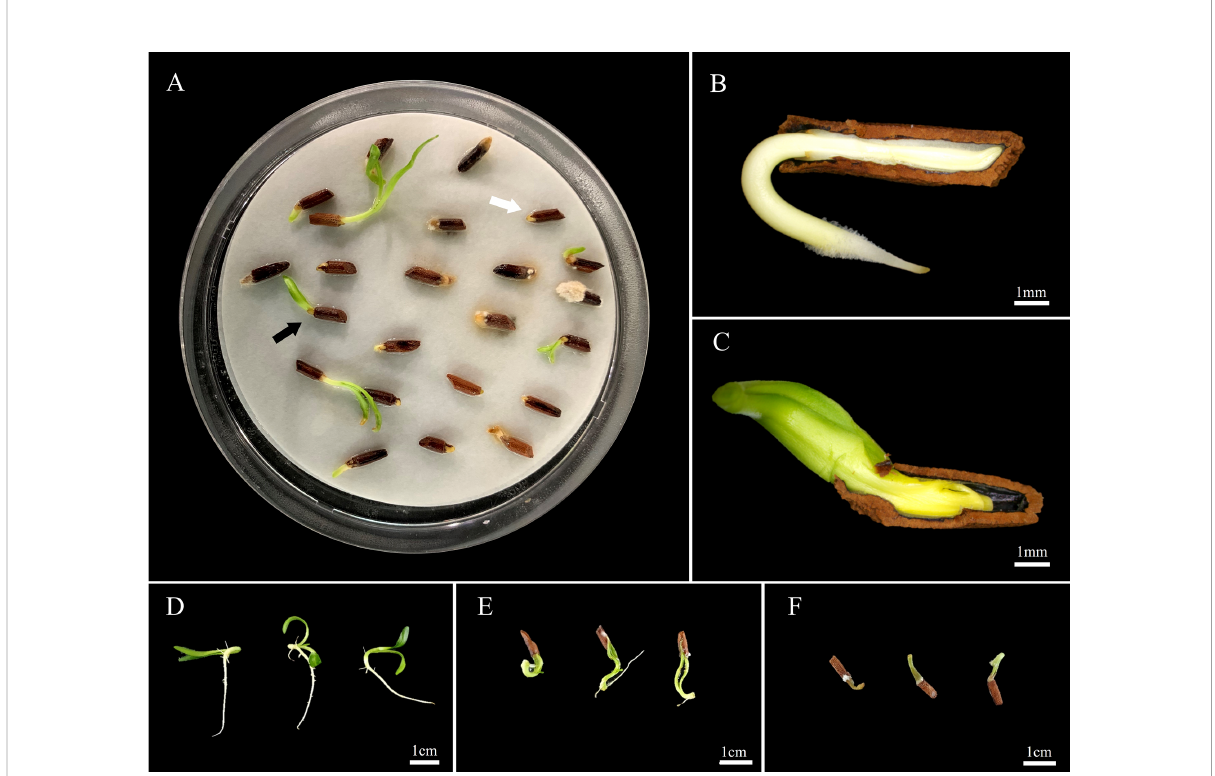
FIGURE 3 Normal and abnormal phenomena observed in germination and seedling emergence after Amsonia elliptica seed scari fi cation. (A) , germination of scari fi ed seeds observed in a Petri dish 14 days after sowing; (B) , the radicle protrudes fi rst and can grow into normal seedlings; (C) , The cotyledon protrudes fi rst, and the radicle fails to protrude, resulting in abnormal growth or death; (D) , normal seedlings; (E) , abnormal seedlings with arrested cotyledons; (F) , abnormal